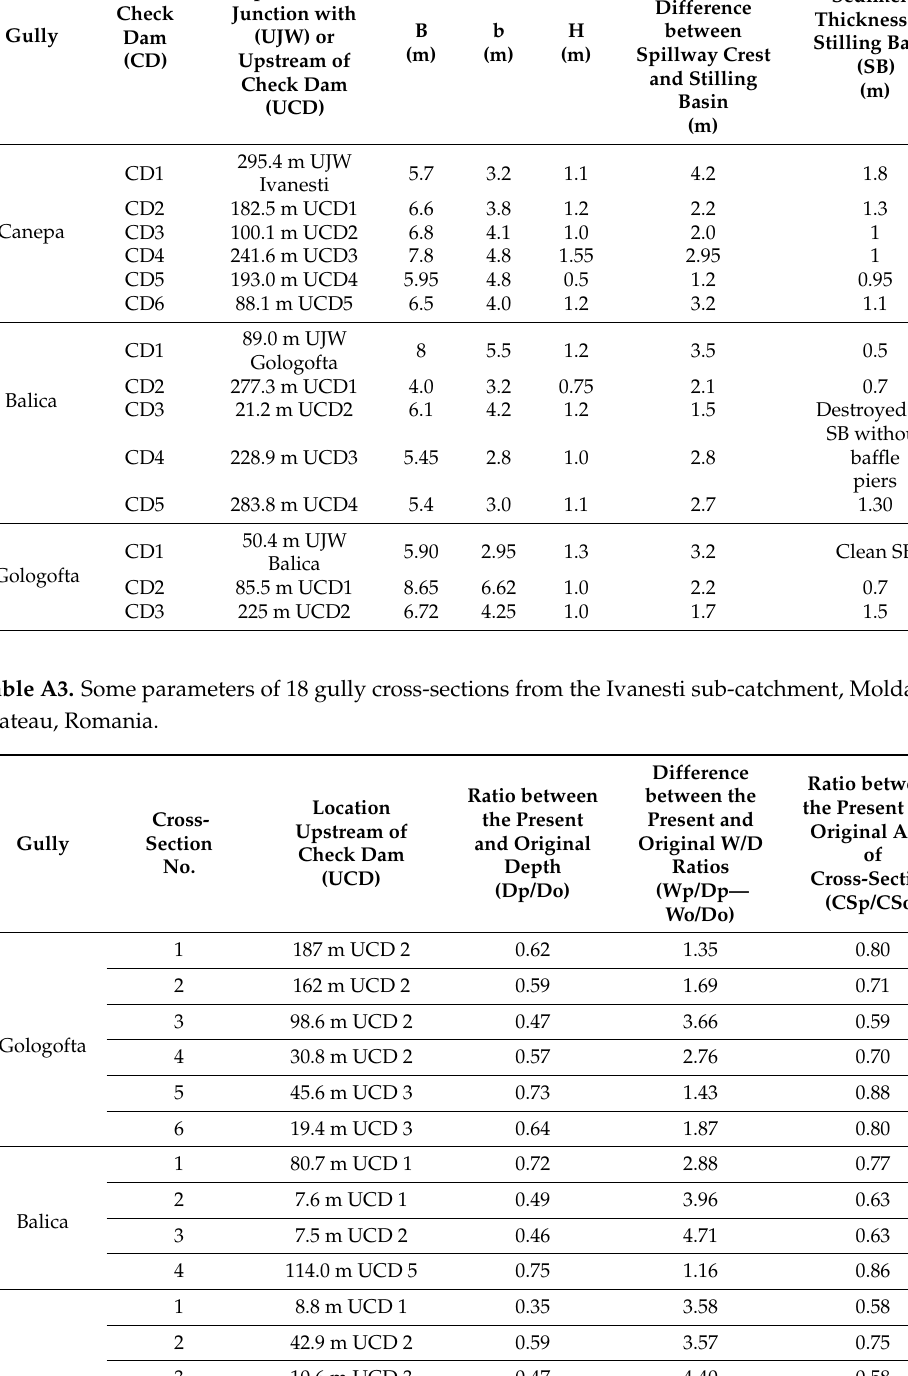
Table A2. Check dams from the Ivanesti sub-catchment, Moldavian Plateau, Romania. Gully